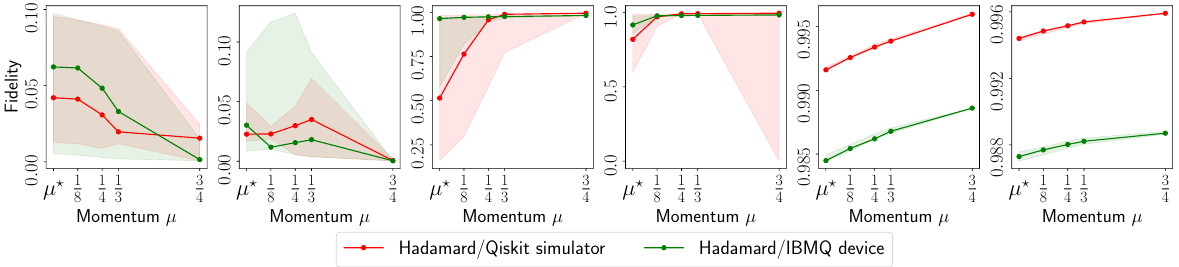
Figure A16. Fidelity list plots for reconstructing Hadamard ( 6 ) circuit using using real measurements from IBM Quantum system experiments and synthetic measurements from Qiskit simulation experiments.